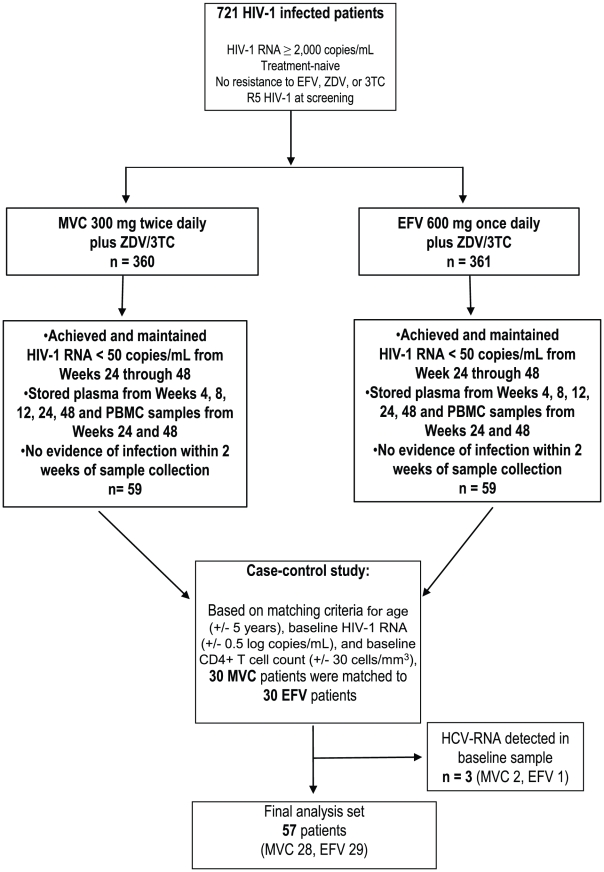
Patient flow chart: MERIT Immune Activation Sub-analysis.Notes under Figure 1: MVC, maraviroc; EFV, efavirenz; ZDV, zidovudine; 3TC, lamivudine.